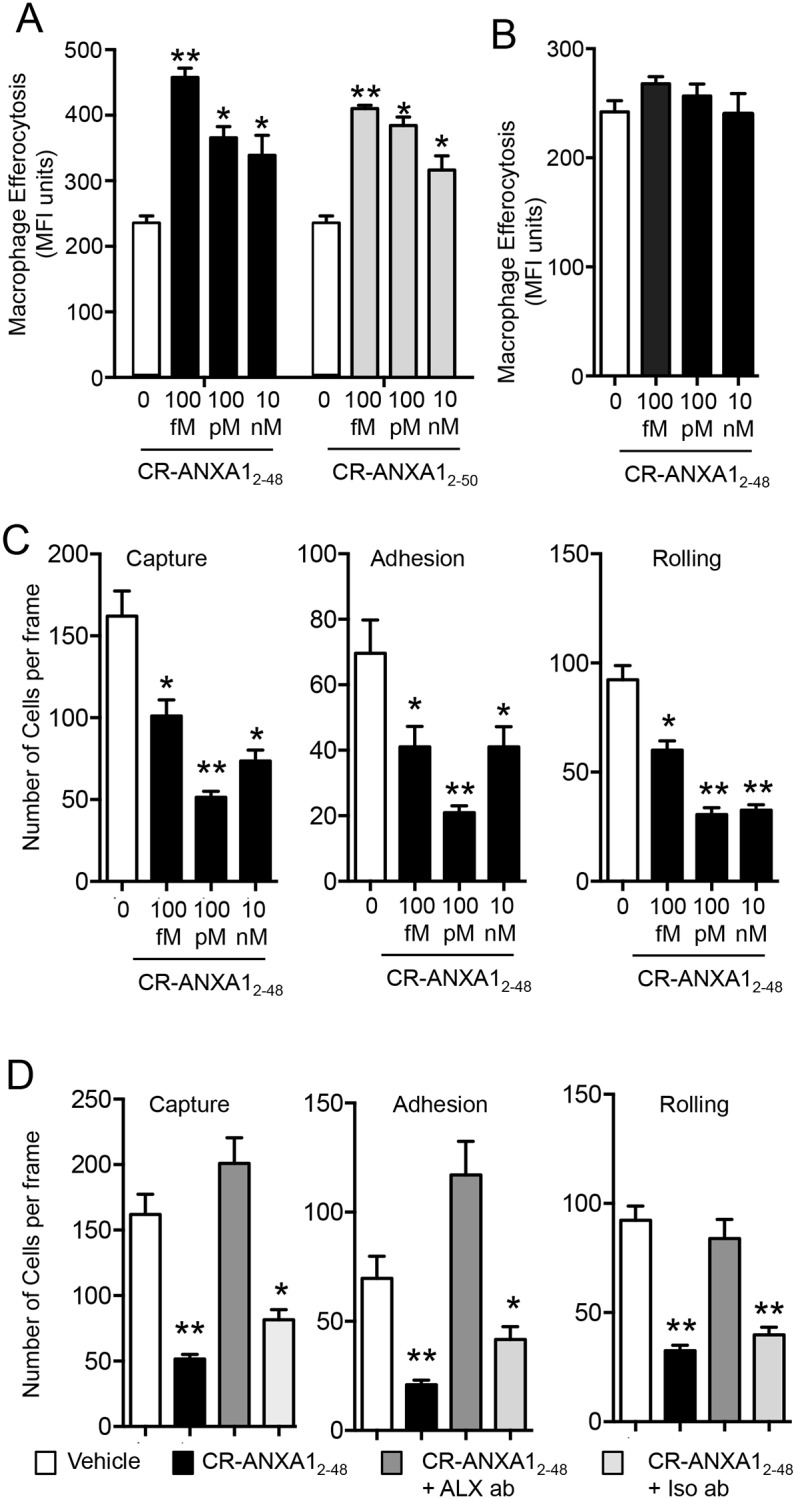
Anti-inflammatory and pro-resolving actions of CR-AnxA12-48 with mouse and human leukocytes.(A) Plots depicting phagocytosis of apoptotic human neutrophils (efferocytosis) by macrophages incubated with or without the indicated concentrations of CR-AnxA12–50 and CR-AnxA12–48. (B) Bar graphs depicting phagocytosis of apoptotic human neutrophils (efferocytosis) by bone marrow derived macrophages from Alx/Fp2/3-/- mice incubated with or without the indicated concentrations of CR-AnxA12–48. Results are mean ± SEM. n = 4 mice per group per time point; *p < 0.05, **p < 0.01, versus vehicle group. (C) Plots depicting the number of human neutrophils interacting with activated human endothelial cells incubated with or without the indicated concentrations of CR-AnxA12–48.. (D) Bar graphs illustrating the number of neutrophils interacting with activated endothelial cells. Results for C,D are mean ± SEM of n = 4 independent cellular preparations *p < 0.05 versus PBS, **p < 0.01 versus vehicle control.